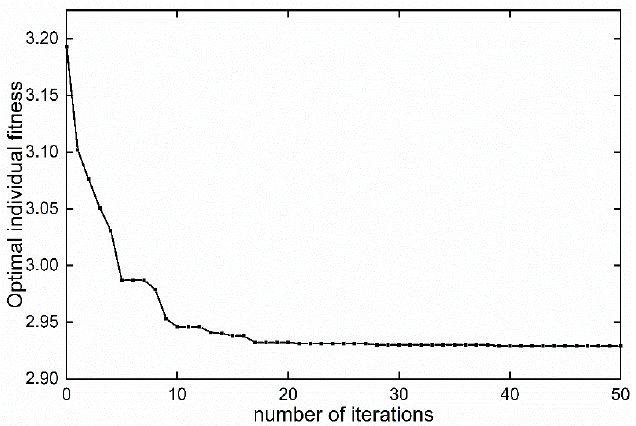
Figure 15. Relationship between optimal individual fitness and number of iterations.